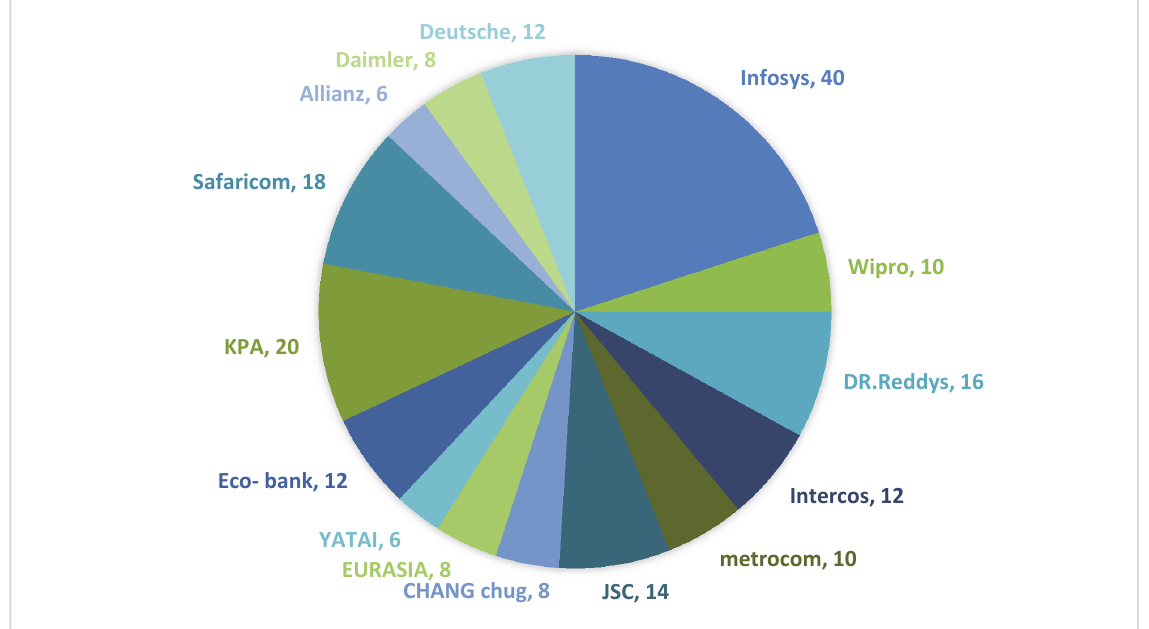
Fig. 2. Company wise distribution of